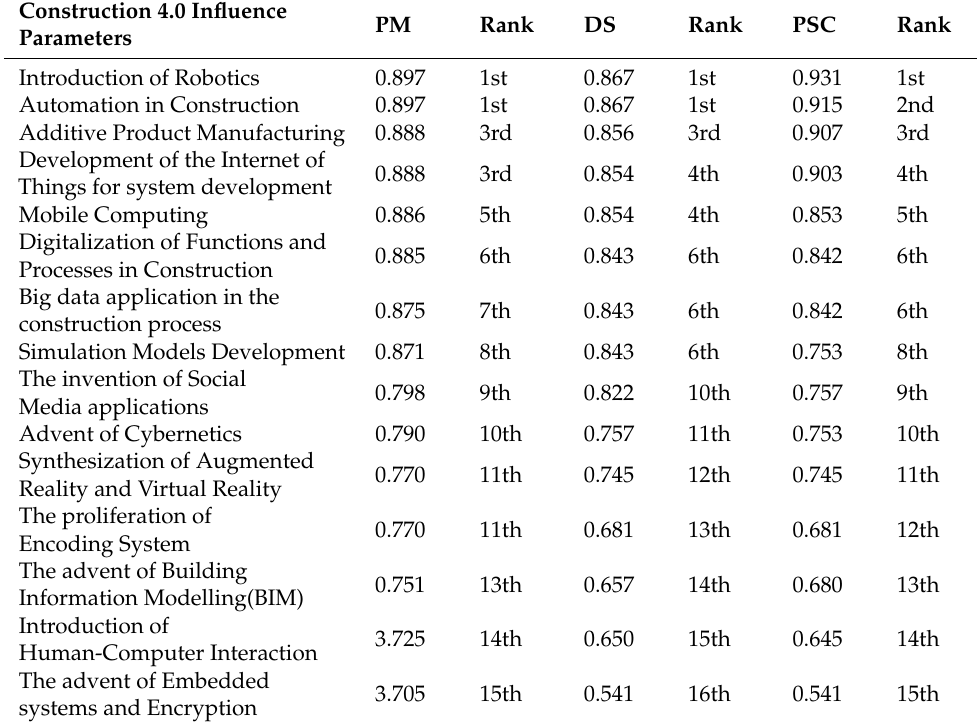
Table 4. Industry 4.0 tools’ impact on quality management process of a construction project. Construction 4.0